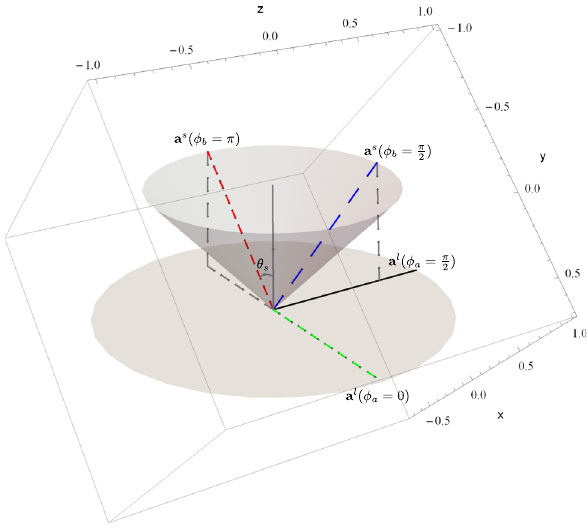
Fig. 1 The effective measuring directions a l and a s . In a certain coor- dinate system, a l (φ l ) is on xy plane, a s (θ s ,φ s ) is on a cone. For B d mesons, φ l = x (cid:4) t , (φ s ,θ s ) = ( x (cid:4) t + π/ 2 , 2 β) , corresponding to fla- vor and CP measurements following evolution of time t , respectively. For photon polarizations, a l and a s are polarizer directions in Bloch representation, and can be adjusted